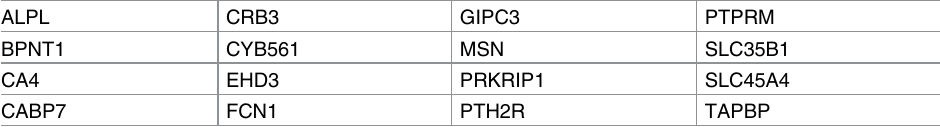
Table 7. Brain EC proteins displaying intracerebral heterogeneous expression. Proteins (n = 16) were identifiedas heterogeneously expressedif in all cortex samples examined,capillaryEC displayedhighly vari- able levels of staining.